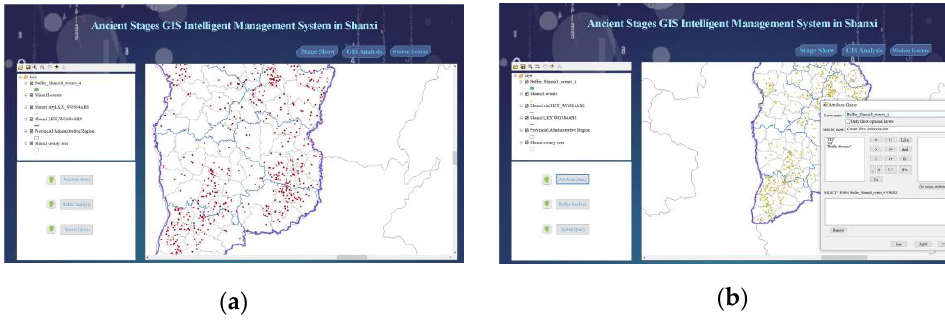
Figure 14. Spatial analysis in GIS. ( a ) Buffer analysis. ( b ) Attribute query.